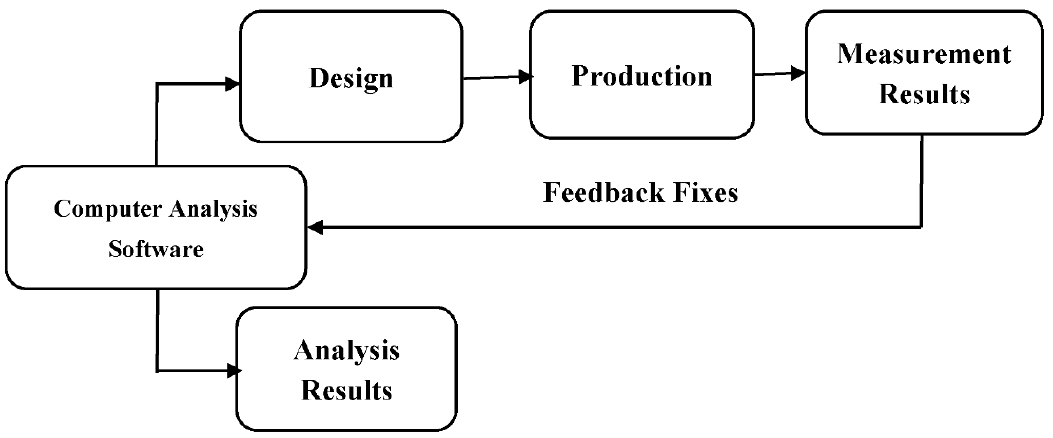
Figure 1. The design procedure of bow-tie microstrip patch antenna.